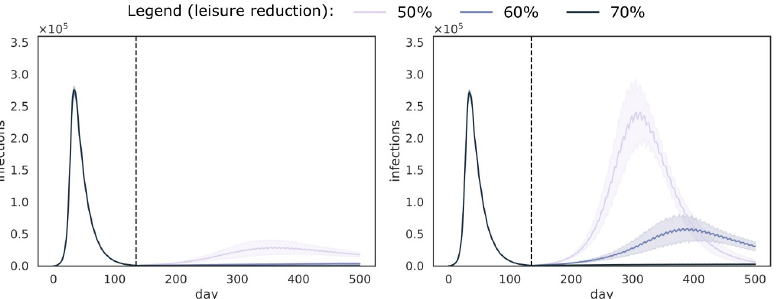
Fig 5. Trends for different leisure contact reductions, when performing weekly universal testing, and importing 10 cases per day. We assume that universal testing starts (and lock-down ends) on the first of July, as marked by the vertical dotted line, and that FNR PCR = 0.1. We consider both isolation strategies: pool isolation (left panel) and individual isolation (right panel). The curves show a line that depicts the average over the trajectories of the result aggregations and a shaded area that depicts the standard deviation.